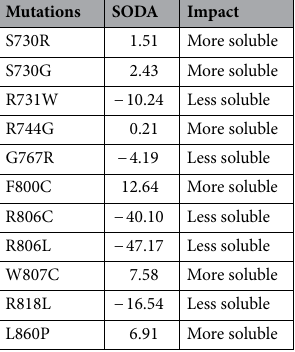
Table 1. Prediction of aggregation propensity of mutant CTC1 protein using SODA server.